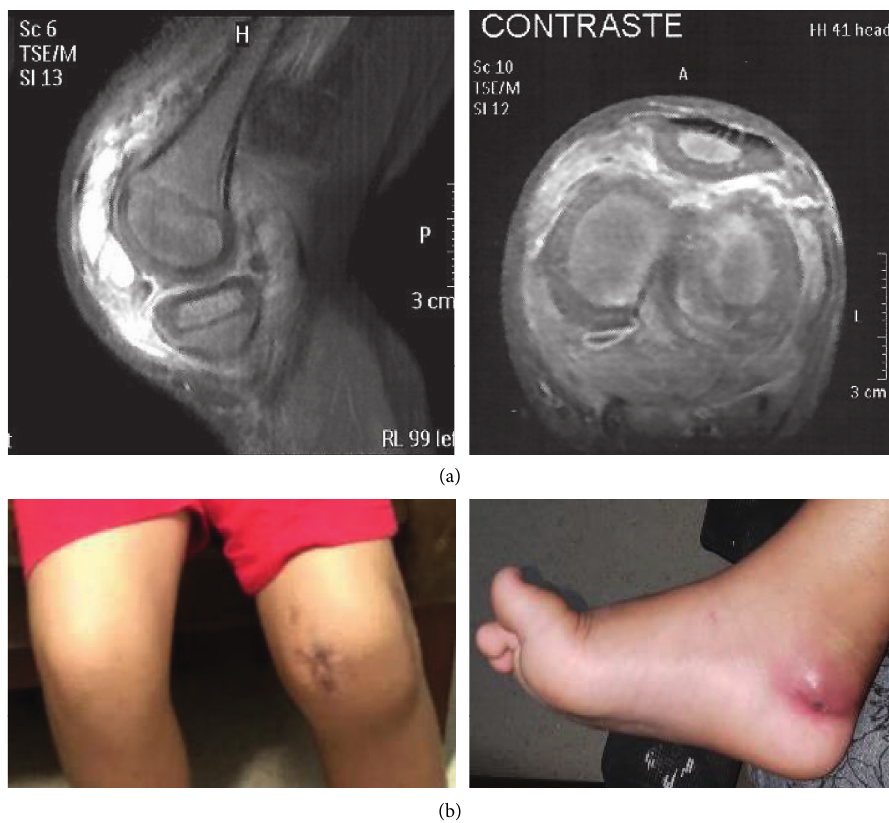
Figure 1: (a) Magnetic resonance imaging of the left knee. Sagittal plane (left); transverse plane (right), T2-weighted contrast. Presence of an extraarticular infiltrative process with involvement of the subcutaneous tissue and epidermis; inflammatory infiltration of adjacent muscle tissue, without evident collections; small foci of inflammatory edema affecting the subcortical bone marrow; extensive synovitis in the patellar recess and intraarticular involvement. In the transverse plane, there is an increase in the inflammatory process, with volumetric impingement of the popliteus neurovascular bundle. (b) Clinical characteristics of the pyoarthritis. Sequelae with increased left knee volume (left); the inflammatory process in the right ankle caused by trauma from the buckle on footwear